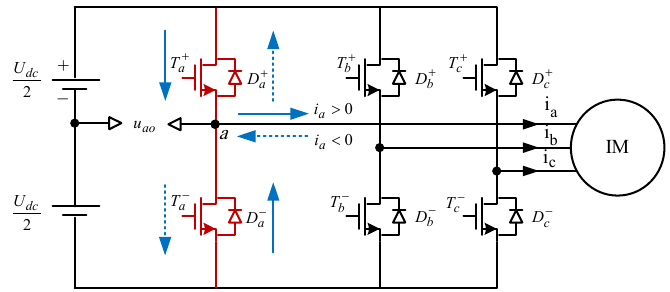
Figure 2. Electric diagram of the three-phase voltage source inverter.